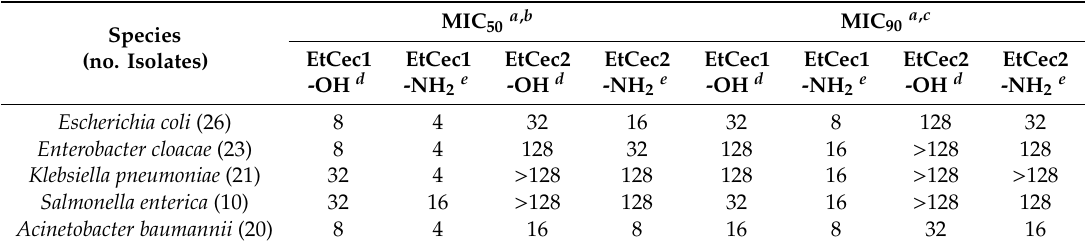
Table 3. Characterization of the MIC value distribution of four AMPs against the clinical isolates.